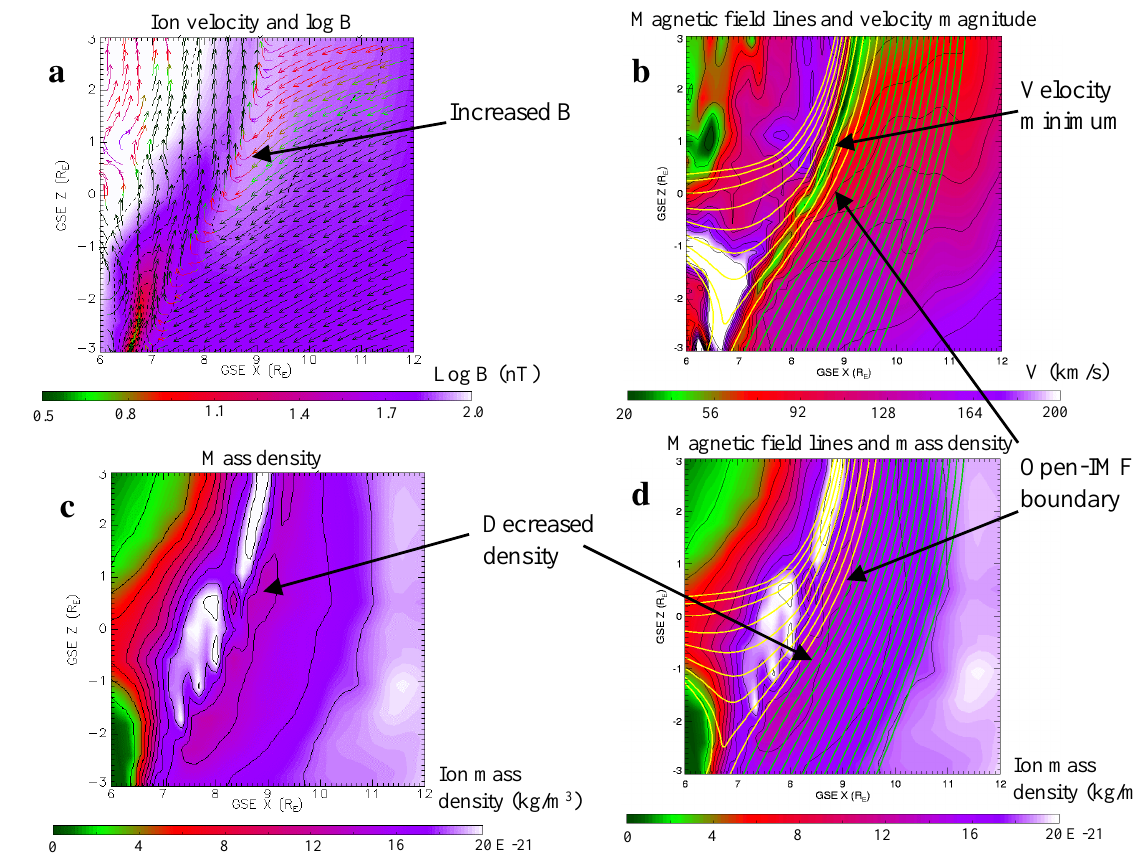
Fig. 7. Details of the shoulder depletion layer depicted in Fig. 6c. All panels display the XZ plane at Y = 0. (a) Ion velocity vectors overlaid on the plane colored with the log of B . (b) Traced magnetic field lines with the velocity magnitude as the background. The yellow field lines are open and connected to the Northern Hemisphere ionosphere. The green field lines are open to the solar wind on both ends. A velocity minimum is seen just inside the open/IMF boundary. (c) Mass density and (d) mass density with the traced magnetic field line overlay. The decreased density and the enhanced B seen in (a) are co-located at the open-IMF boundary.